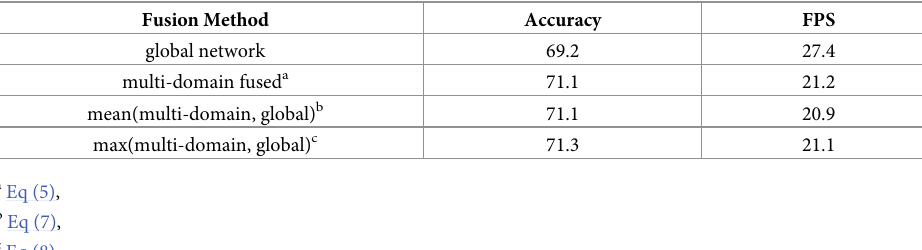
Table 4. Ablation study of fusion method.